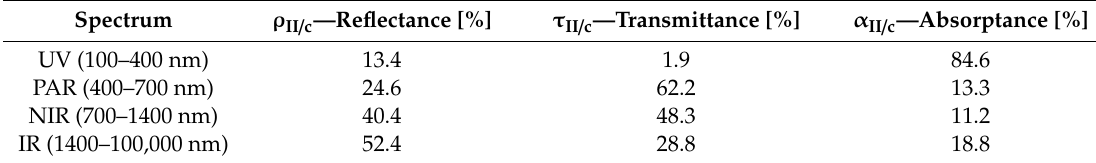
Table 5. Optical properties for the combination of structure II / PE cover.